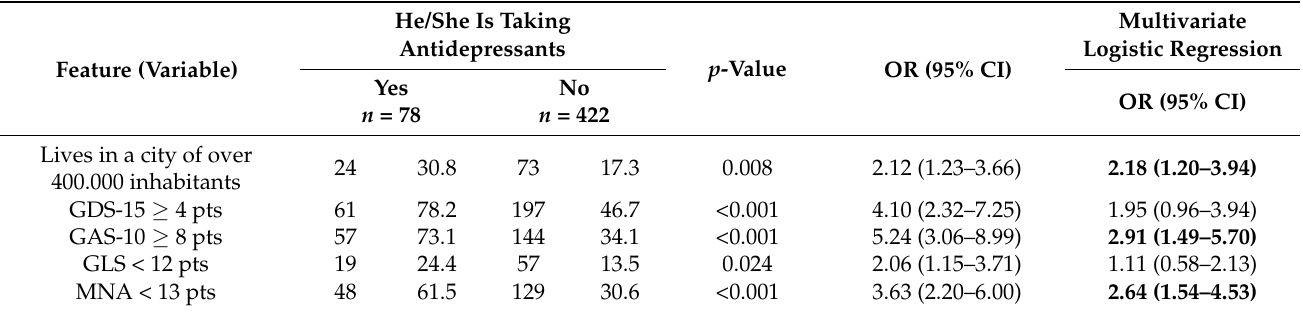
Table 9. Sociodemographic, clinical and mental characteristics in groups that differ in antidepressant drug intake and test